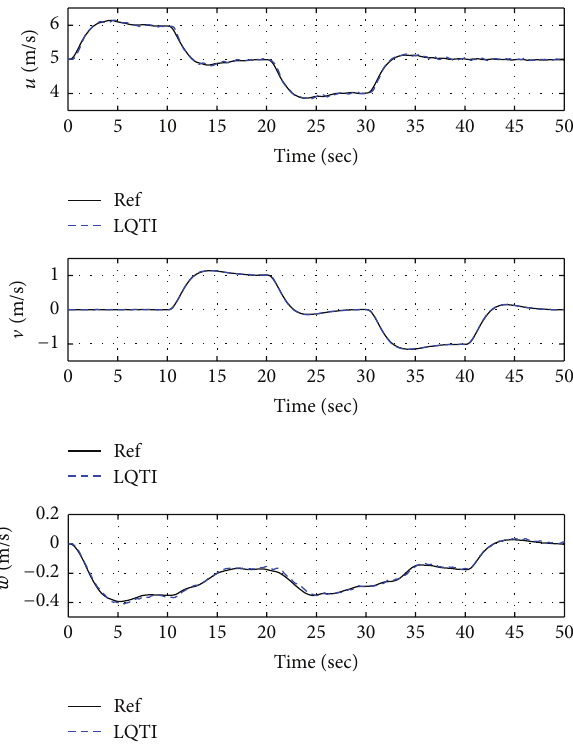
Figure 20: Time histories of velocity at transition mode (Case 2). Transition mode